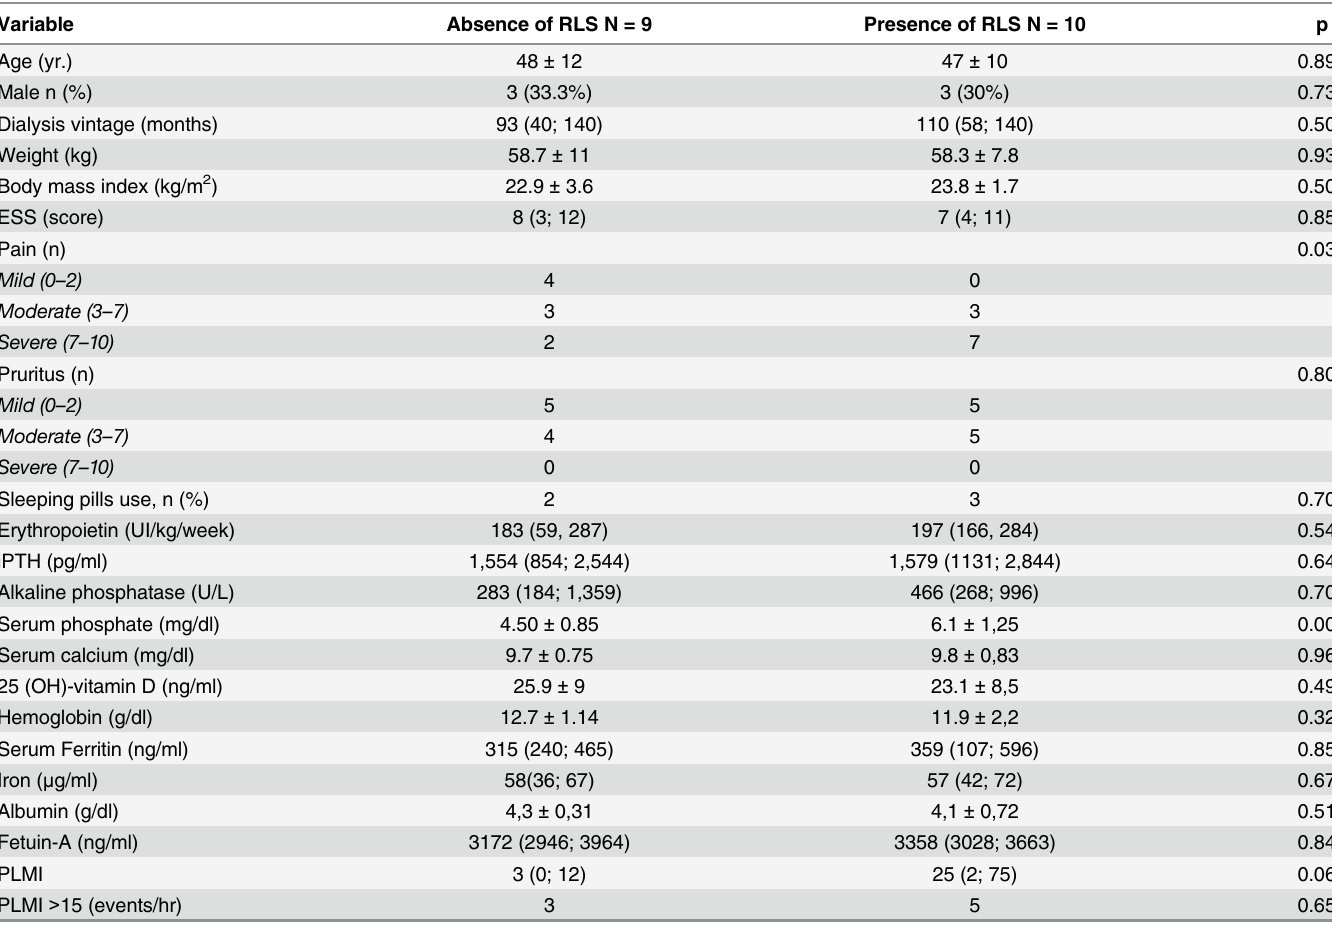
Table 1. Clinical and demographic characteristics stratified by the presence or absence of restless leg syndrome (RLS). Variable Absence of RLS N = 9 Presence of RLS N = 10 p Age